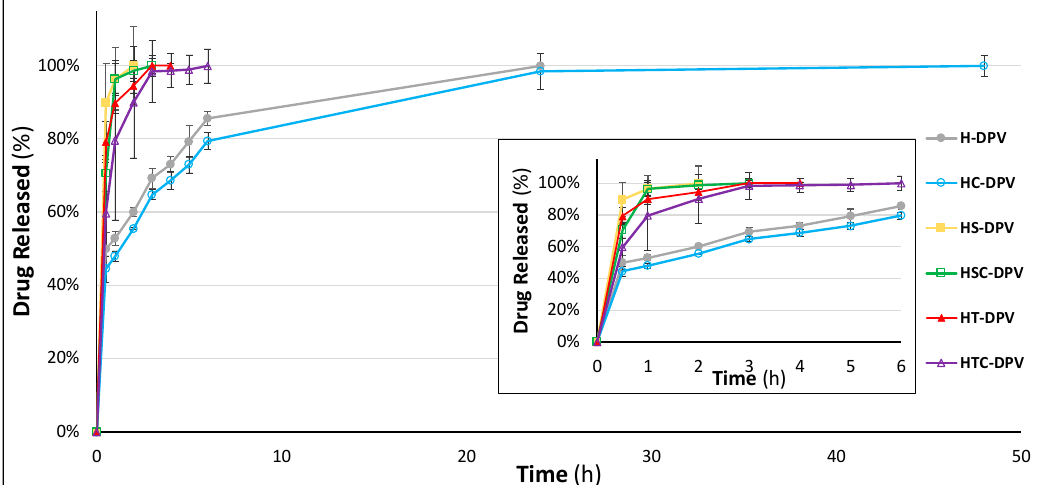
Figure 11. Drug release profiles of DPV-loaded vaginal discs in modified simulated vaginal fluid (including 5% SDS). The values obtained up to 6 h of trial are expanded inside the picture. Mean ± SD are presented ( n = 3).